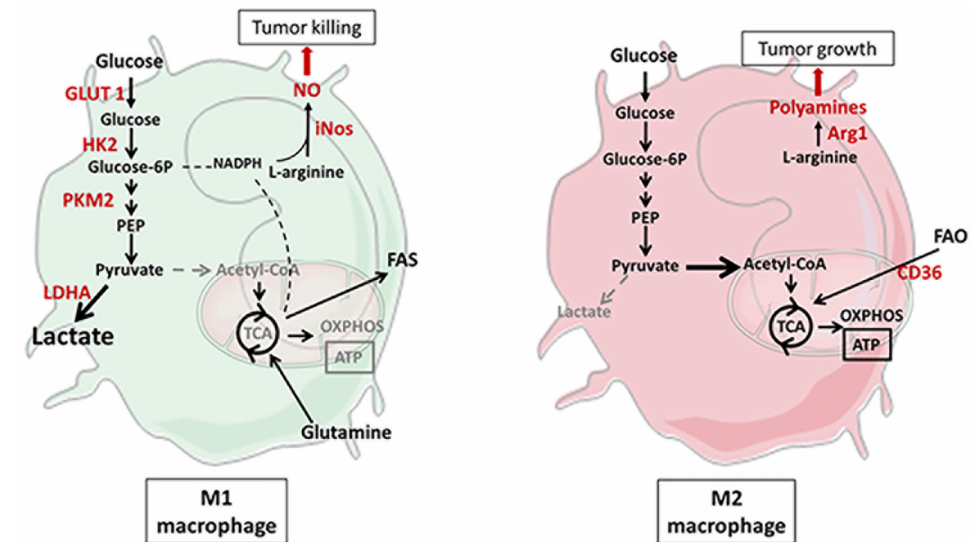
Figure 3. Activation of myeloid cells through metabolic modifications. In polarized M1 macrophages, the PI3K pathway and overexpression of HIF-1 α promote glycolysis via an increase in glycolytic enzymes GLUT1, HK2, PKM2 and LDHA. Glutamine is metabolized in the TCA cycle to support the synthesis of FAs and nicotinamide adenine dinucleotide phosphate (NADPH). NADPH is then converted by inducible nitric oxide synthase (iNOS) into L-arginine and nitric oxide (NO) which play a major role as cytotoxic effector molecules against tumor cells ( left ). Like Tregs, the proliferation of polarized M2 macrophages is supported by FA oxidation. Lipids carried by the CD36 transporter are oxidized through the TCA cycle to produce ATP through oxidative phosphorylation (OXPHOS). In M2, the enzyme arginase 1 (Arg1) converts L-arginine to polyamine to support tumor growth ( right ). ATP: adenosine triphosphate; APC: antigen-presenting cell; Arg1: arginase 1; FAO: fatty acid oxidation; FAS: fatty acid synthase; GLUT1: glucose transporter 1; HIF-1 α : hypoxia- inducible factor 1 α ; HK2: hexokinase 2; iNOS: inducible nitric oxide synthase; LDHA: lactate dehydrogenase A; M1: macrophage 1; M2: macrophage 2; MHC: major histocompatibility complex; NADPH: nicotinamide adenine dinucleotide phosphate; NO: nitric oxide; PKM2: pyruvate kinase M2; TCA: tricarboxylic